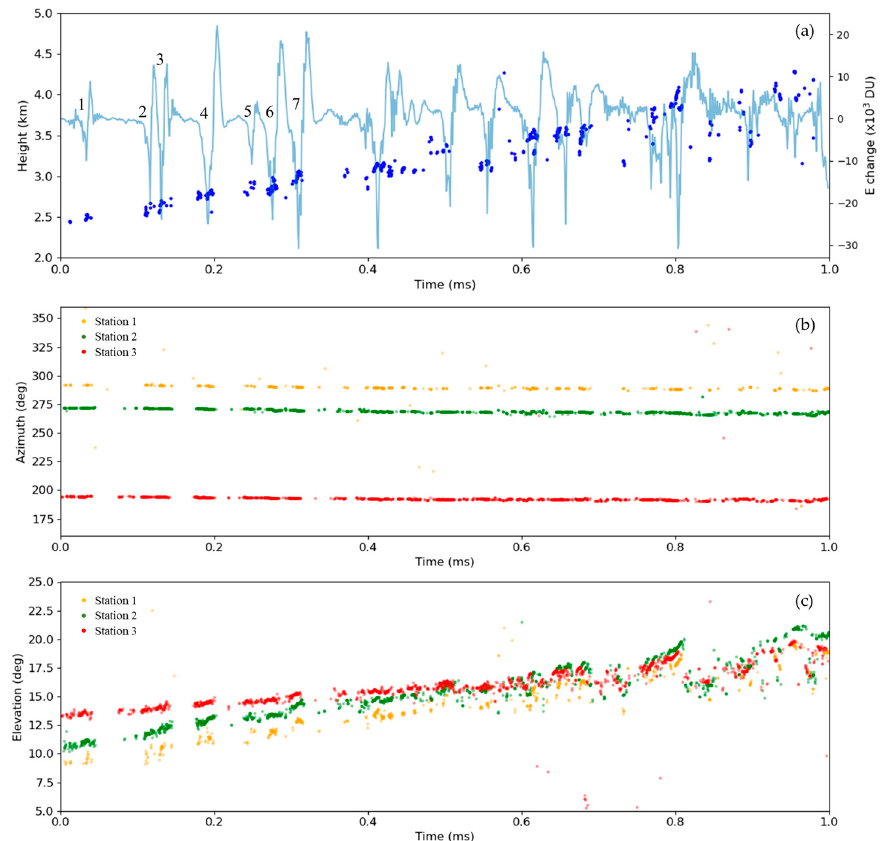
Figure 11. Mapping results for the PB pulses occurred during the initial 1 ms stage. ( a ) 3D mapping by InLMA along with the E-field change. The pulses numbered from one to seven have a simple structure and will be studied further next; ( b ) Azimuth versus time for all three InLMA stations; ( c ) Elevation versus time for all three InLMA